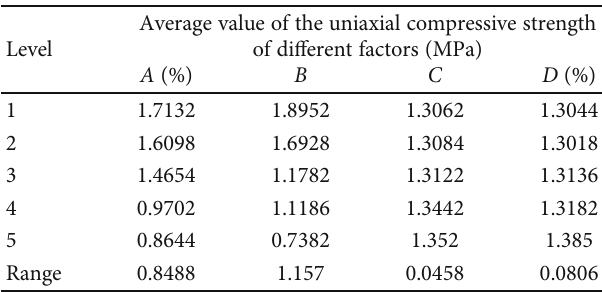
Table 5: Range analysis of the uniaxial compressive strength.